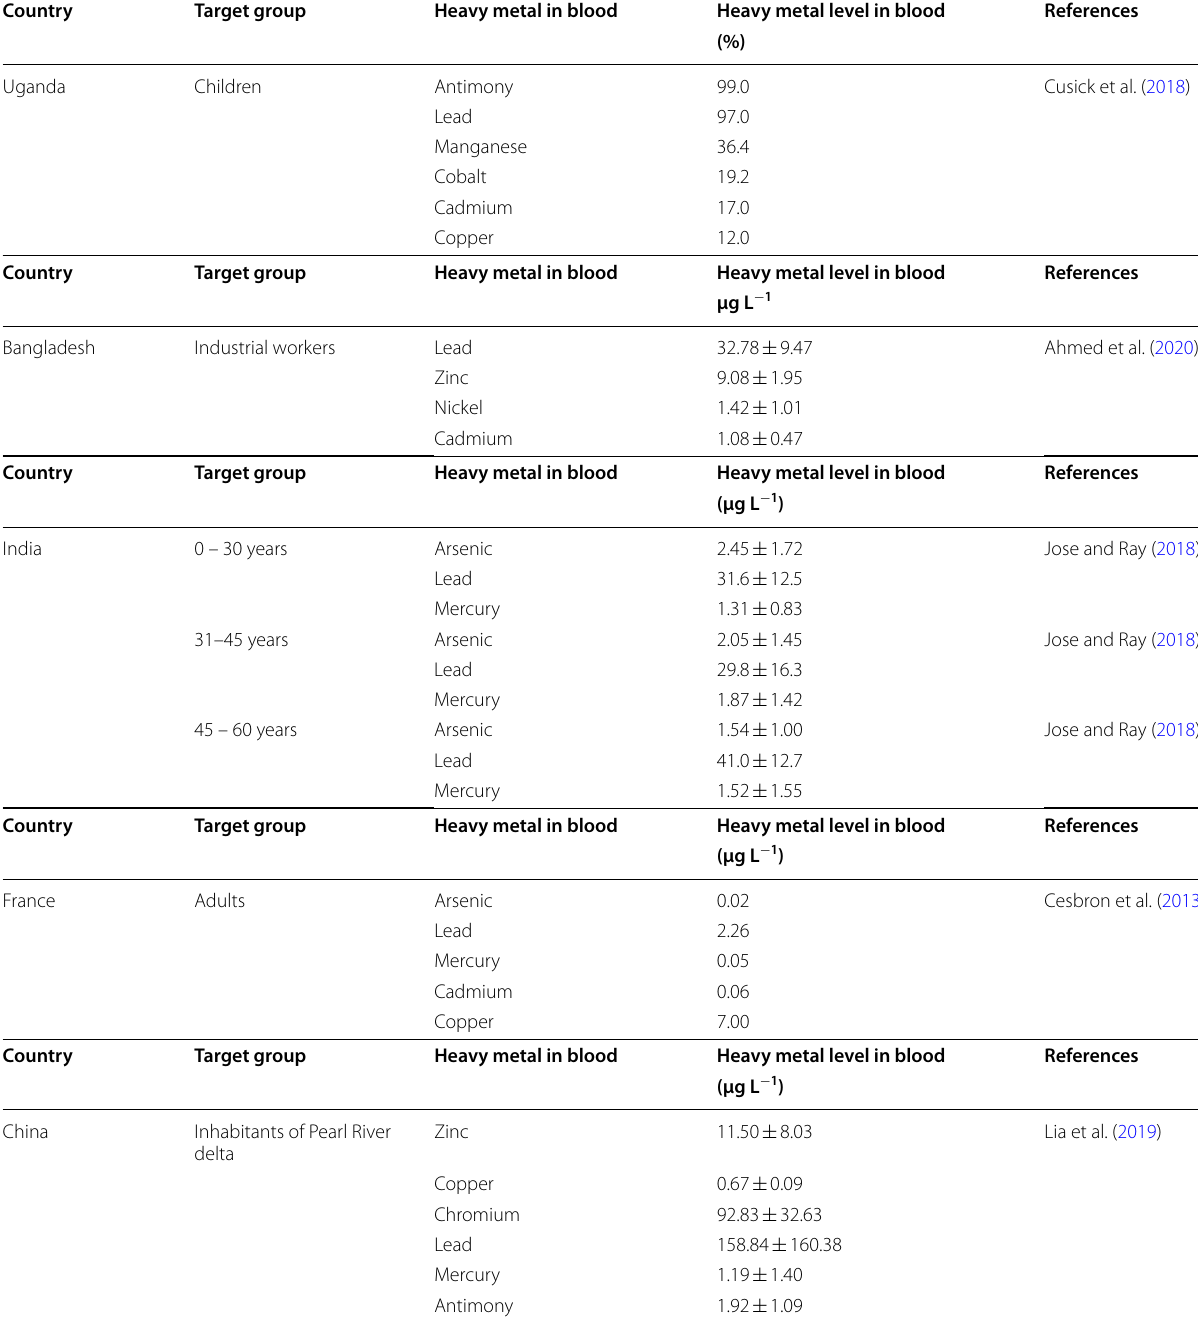
Table 3 Selected heavy metal concentrations in blood from various countries